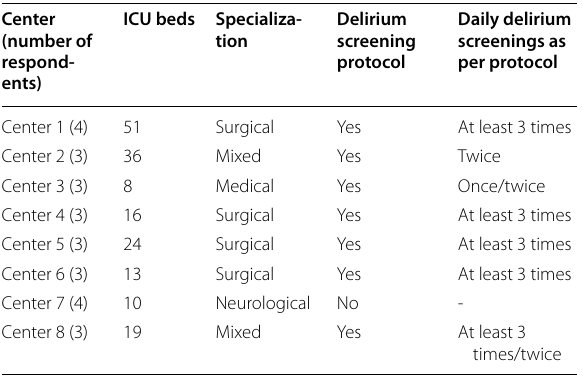
Table 1. Delirium screening practices in centers according to ICU staff